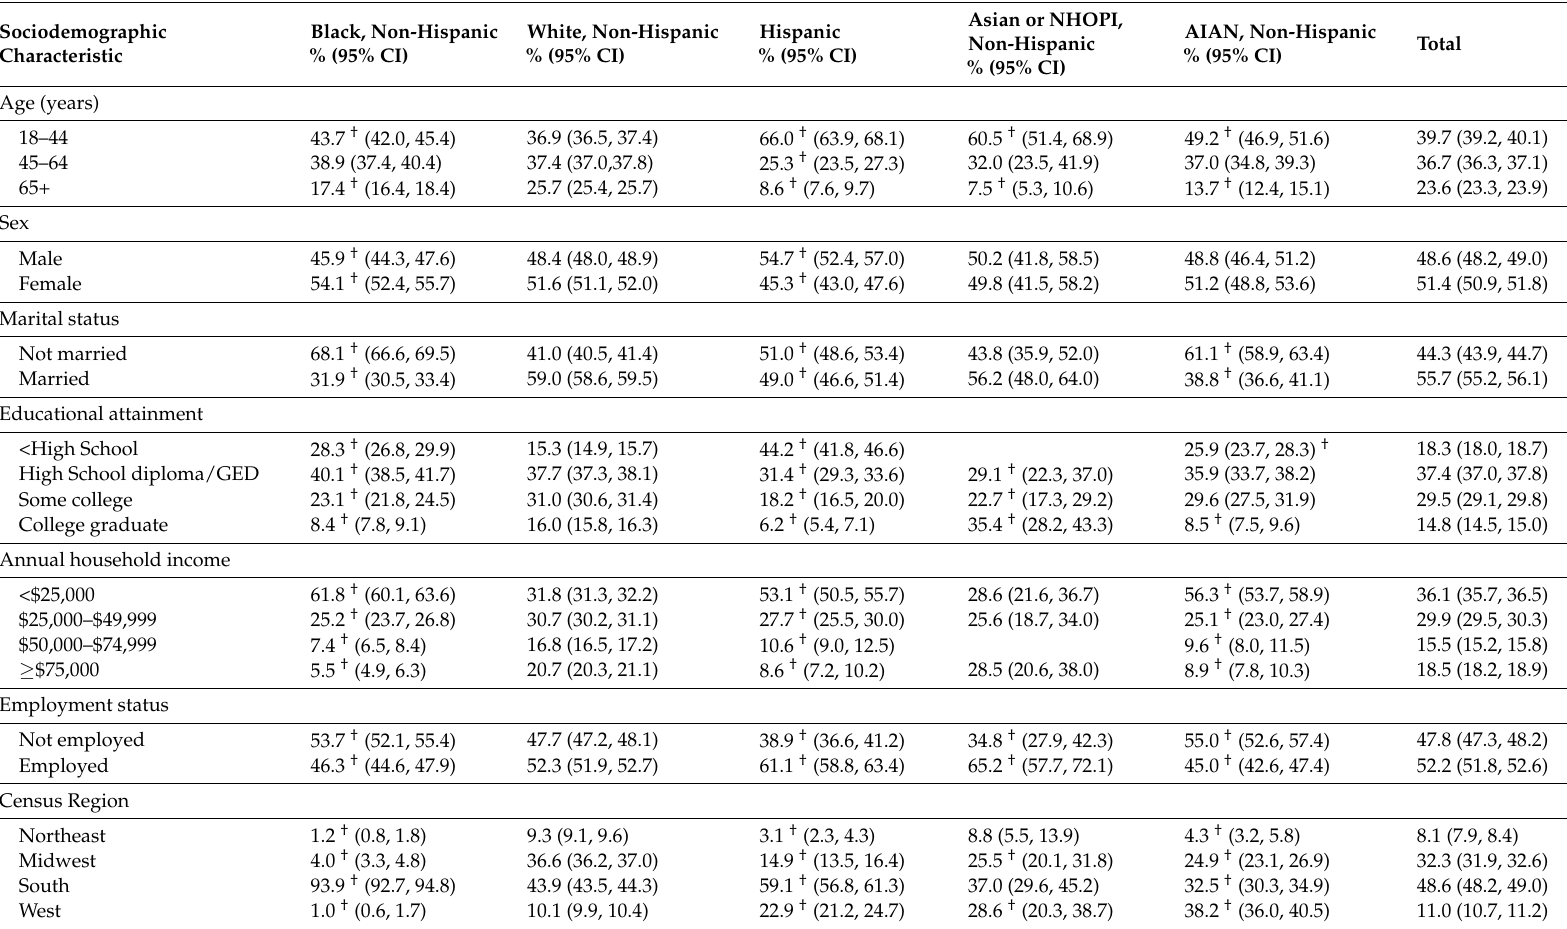
Table 1. Sociodemographic characteristics of rural dwelling adults * by race and ethnicity: Behavioral Risk Factor Surveillance System, United States, 2012–2015. Sociodemographic